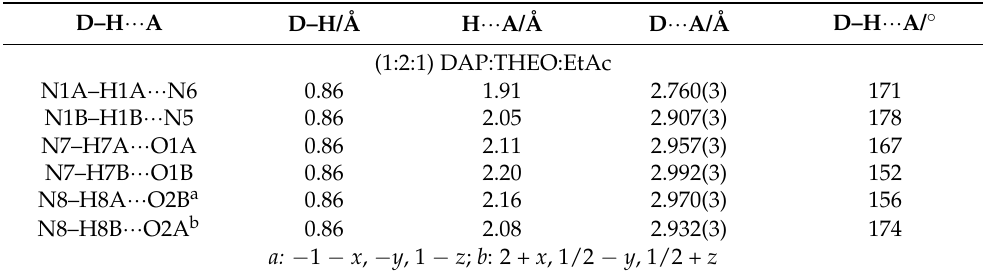
Table 2. Hydrogen bonds in (1:2:1) DAP:THEO:EtAc